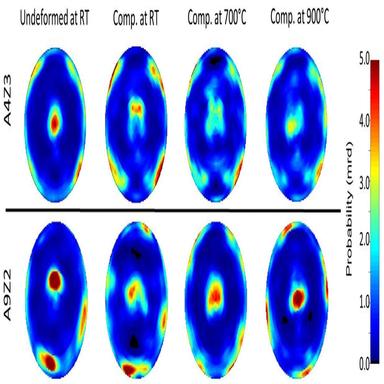
E-WIMV algorithm texture results of the FCC peak for the undeformed sate and RT and deformed 20% comp. strain at RT, 700 °C, and 900 °C for A4Z3 (top row) and A9Z2 (bottom row). Building and loading direction are normal to the pole figures. For colors, please see digital version.